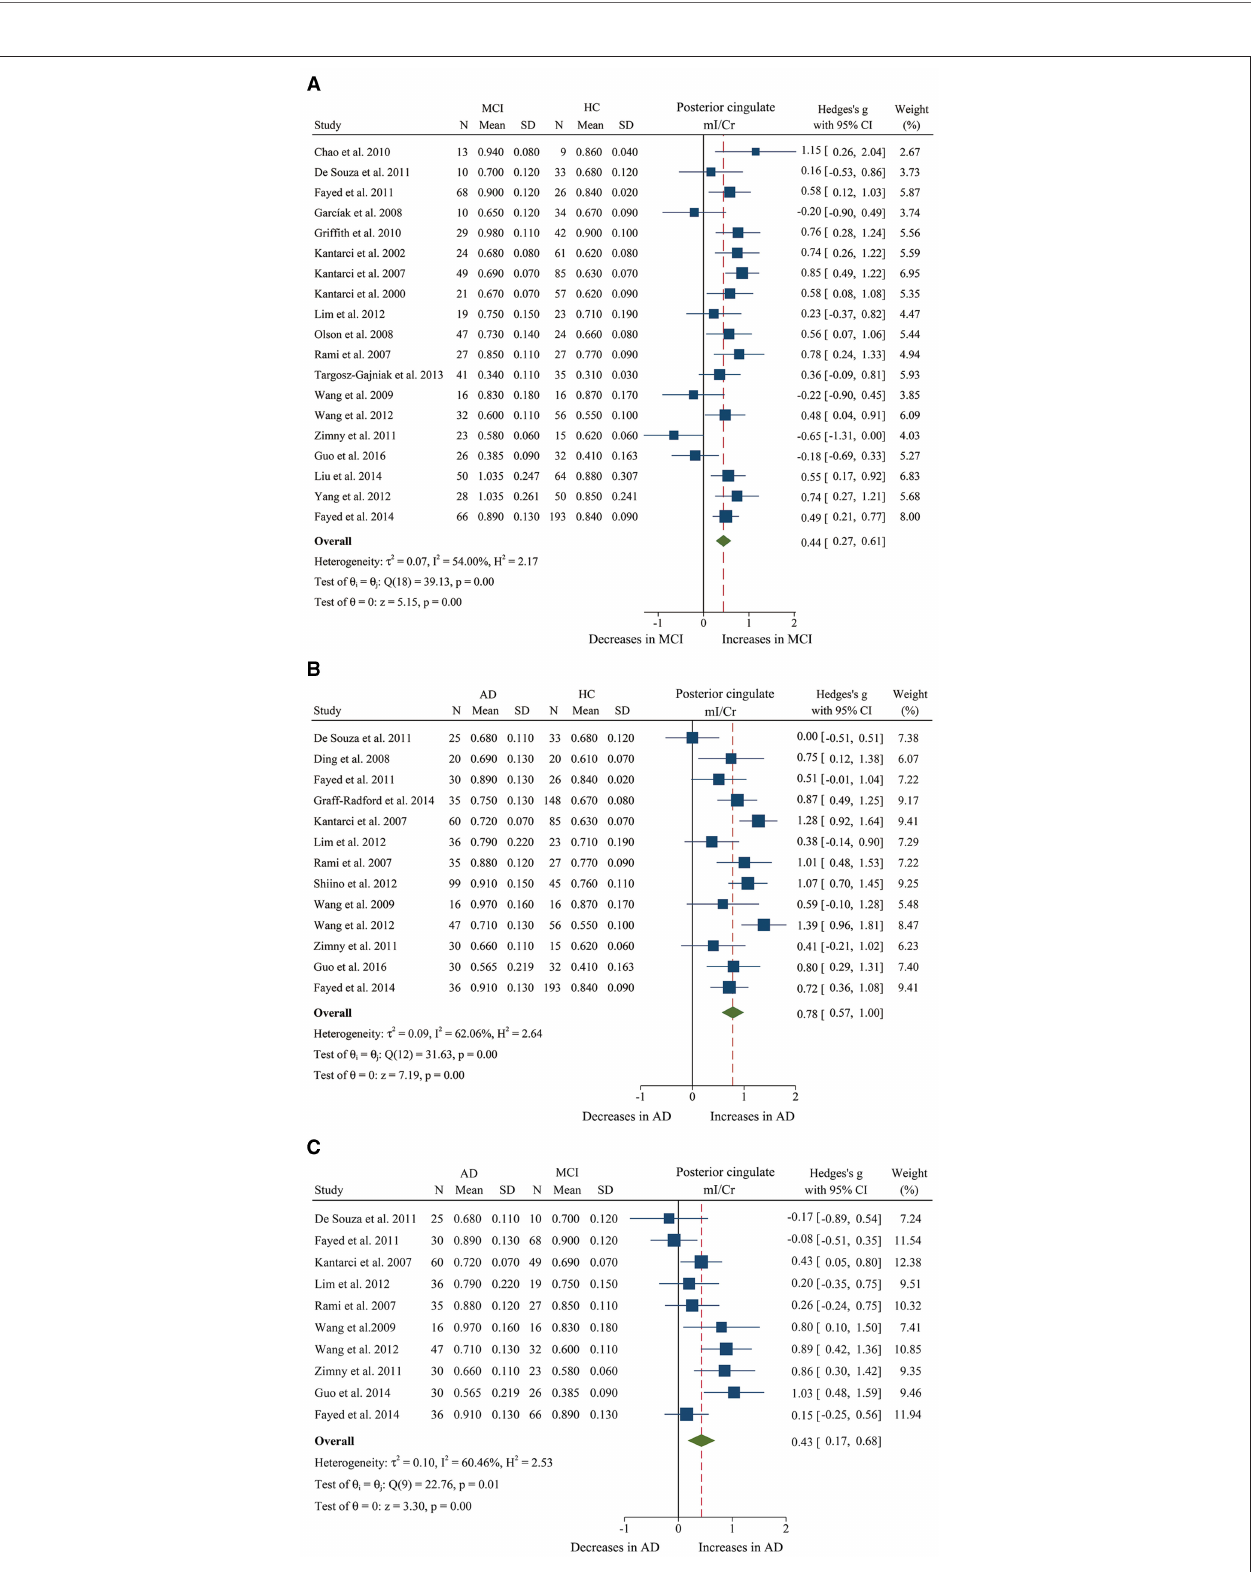
Frontiers in Aging Neuroscience |